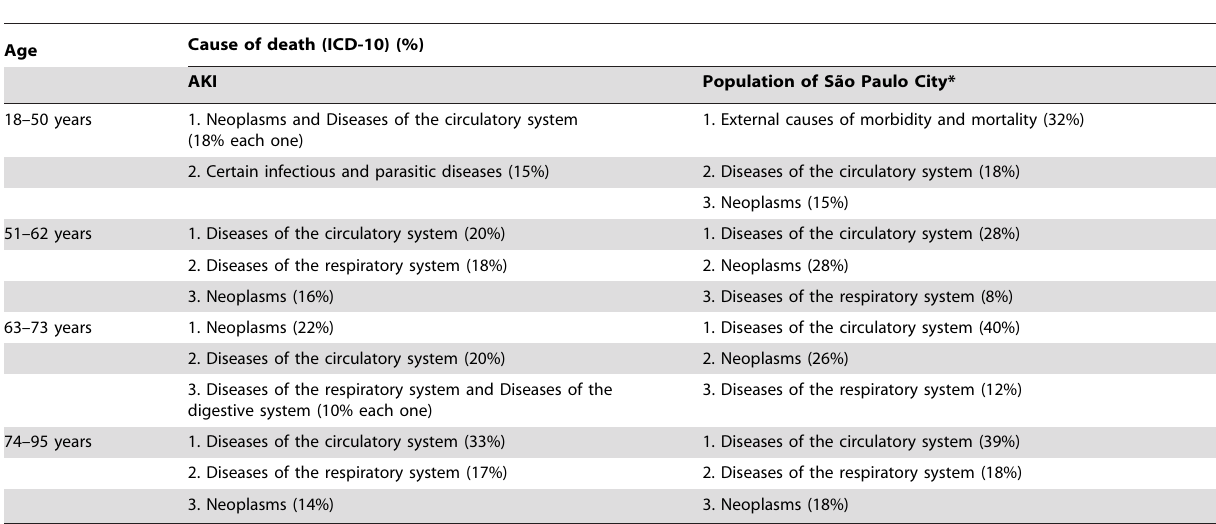
Table 4. Causes of death of the patients with acute kidney injury and of the Sa˜o Paulo